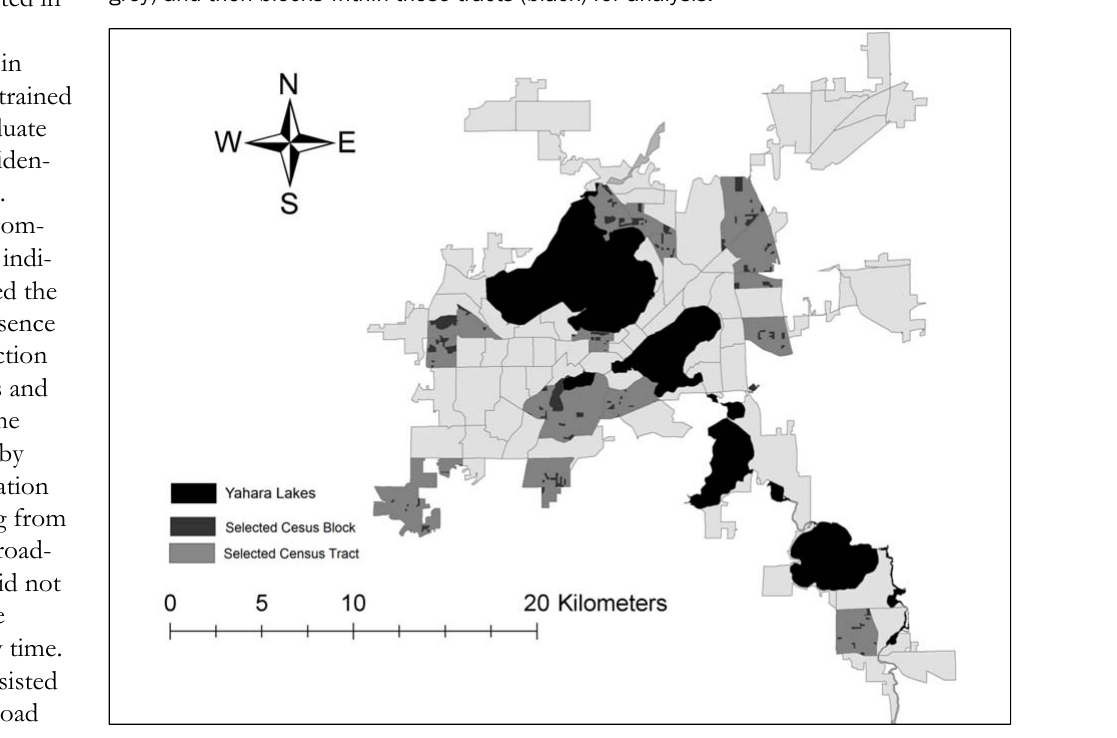
Figure 3. Madison Urban Area (MUA) Garden Sampling Design A mulitistage random stratified probability sample was used to select census tracts (dark grey) and then blocks within those tracts (black) for